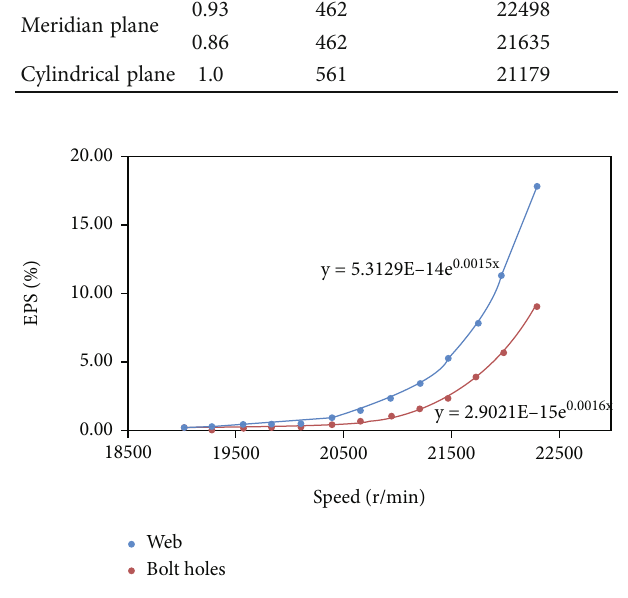
Figure 10: Fitted curves for EPS versus rotational speed. Table 6: Burst speed results from local stress and strain